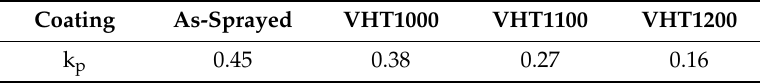
Table 4. Parabolic rate constant of coatings oxidized at 1100 ◦ C.